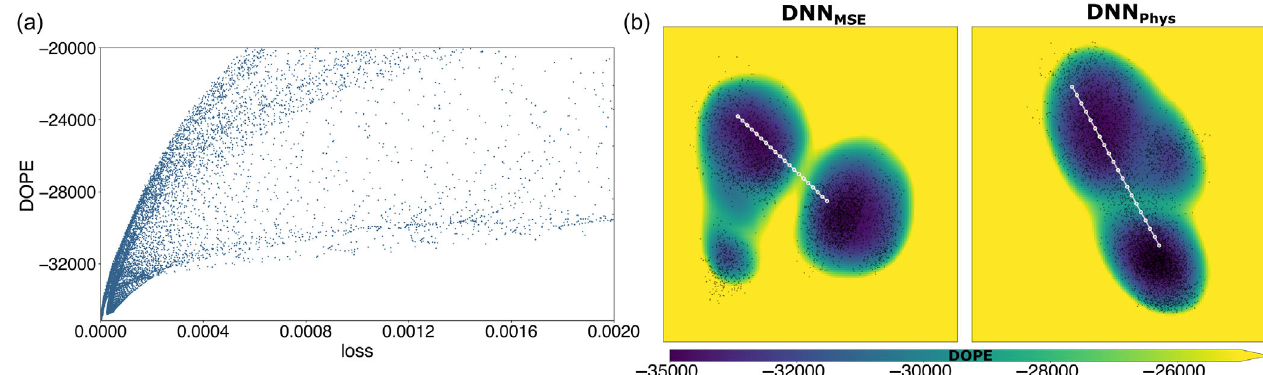
FIG. 3. Analysis of latent spaces of networks trained on conformations of MurD “ open ” and “ closed ” states. (a) The physics-based loss function used to train our neural network correlates with the DOPE score, making it a reasonable estimator of protein structural quality. (b) DOPE scores corresponding to the latent spaces of our neural network trained with two different loss functions. On the left, the network is trained to only minimize mean square error (MSE) between input and output structure; on the right, the loss function combines MSE and a physics-based loss function (DDN). Yellow regions indicate structures of poor quality, black points report on the projection in the latent space of all training examples, including the generated midpoints z m used to train DDN. The transition path predicted by the networks is projected as connected white dots onto their respective latent space. The latent space of the network based solely on MSE features two basins associated with closed and open states, separated by a region of poor quality models. In the network trained with both MSE and physics (DNN ), the two states are connected by acceptable protein models. Also see Fig. S4 comparing Phys the structures from the identified basins (Supplemental Material